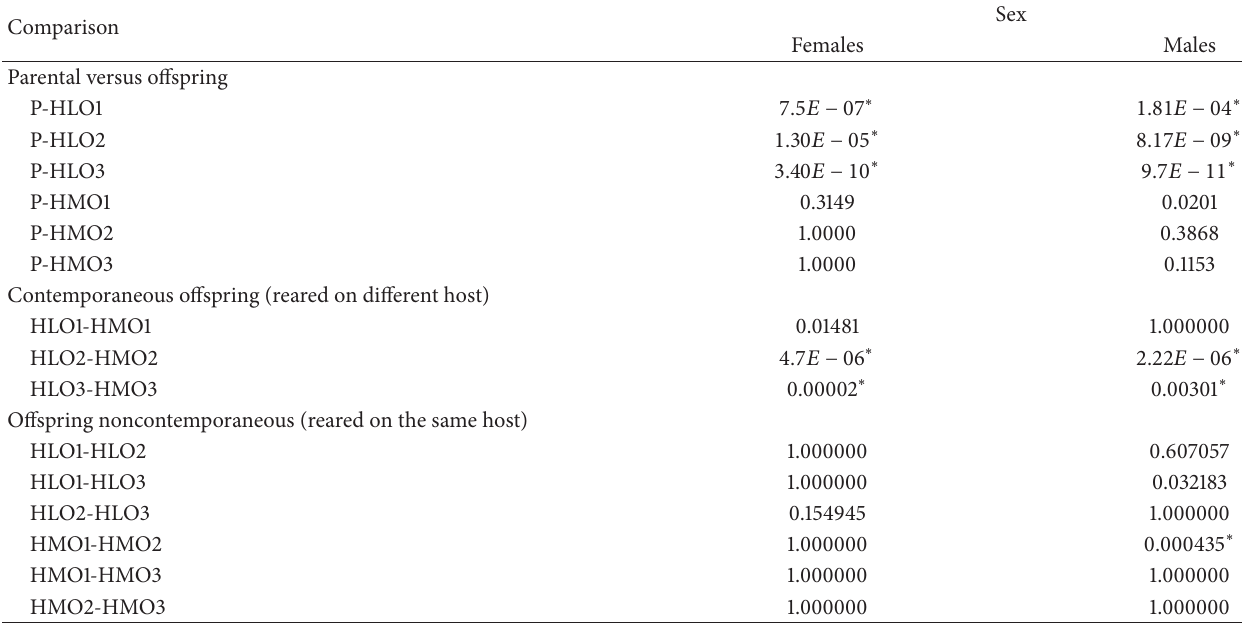
Table 2: Comparison of centroid size of B. ferroae, between parental and progeny reared under laboratory conditions with two different hosts: cockroaches and mice (Kruskal-Wallis